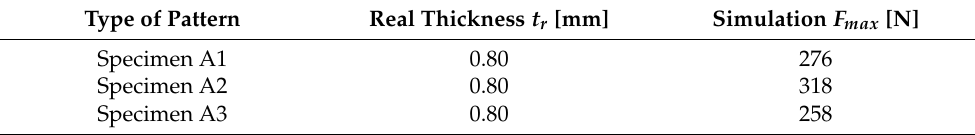
Figure 12. The plastic strain field corresponding to the failure load F max = 276 N for specimen A1, real thickness t r = 0.80 mm. Table 10. Calculated values of load-bearing